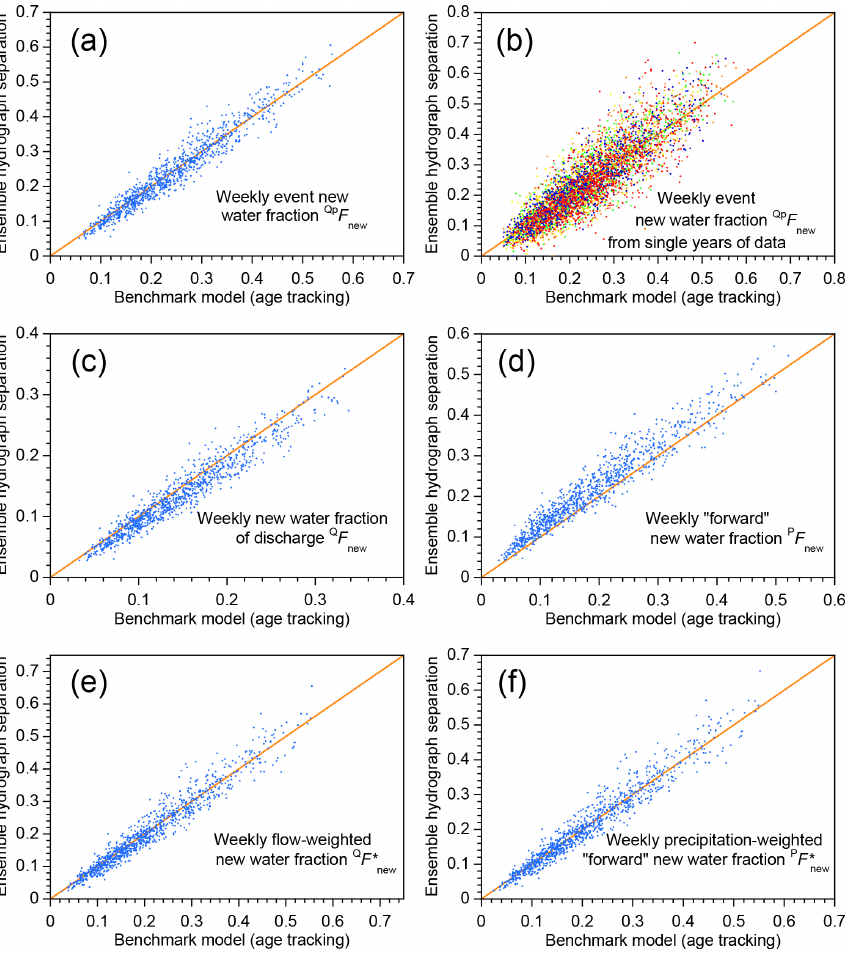
Figure 5. New water fractions estimated from weekly tracer dynamics using ensemble hydrograph separation, compared to averages of time-varying new water fractions determined from age tracking in the benchmark model. Plots are similar to those in Fig. 2, except here they are derived from simulated weekly sampling of tracer concentrations in precipitation and streamflow. Diagonal lines show perfect agreement. Each scatterplot shows 1000 points, each representing an individual random set of parameters, a randomly generated precipitation tracer time series, and a random set of measurement errors and missing values (see Sect. 3.1). The daily precipitation amounts are the same (Smith River time series) in each case. The event new water fraction (a, b) is the average fraction of new (same-day) water in streamflow during time steps with precipitation, as described in Sect. 2.3. Panel (a) shows event new water fractions estimated from 5 years of simulated weekly tracer data; panel (b) shows the same quantity estimated from single years of simulated weekly tracer data (each year is denoted by a different color). Averaging over the 5 years reduces scatter compared to the individual-year estimates. The new water fraction of discharge (c) is the fraction of same-day precipitation in streamflow, averaged over all time steps including rainless periods (Eq. 14, Sect. 2.4); its flow-weighted counterpart (e) is calculated using Eqs. (16)–(18) of Sect. 2.5. The forward new water fraction (the fraction of precipitation that becomes same-day streamflow; d ) is calculated using Eq. (21), and its precipitation-weighted counterpart (f) is calculated using Eq. (28). There is only slight visual evidence of bias, and the scatter around the 1 : 1 line is small compared to the range spanned by the new water